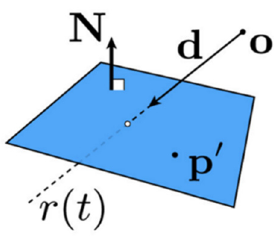
Figure 3. Calculation process of the intersection point between plane p and ray r.